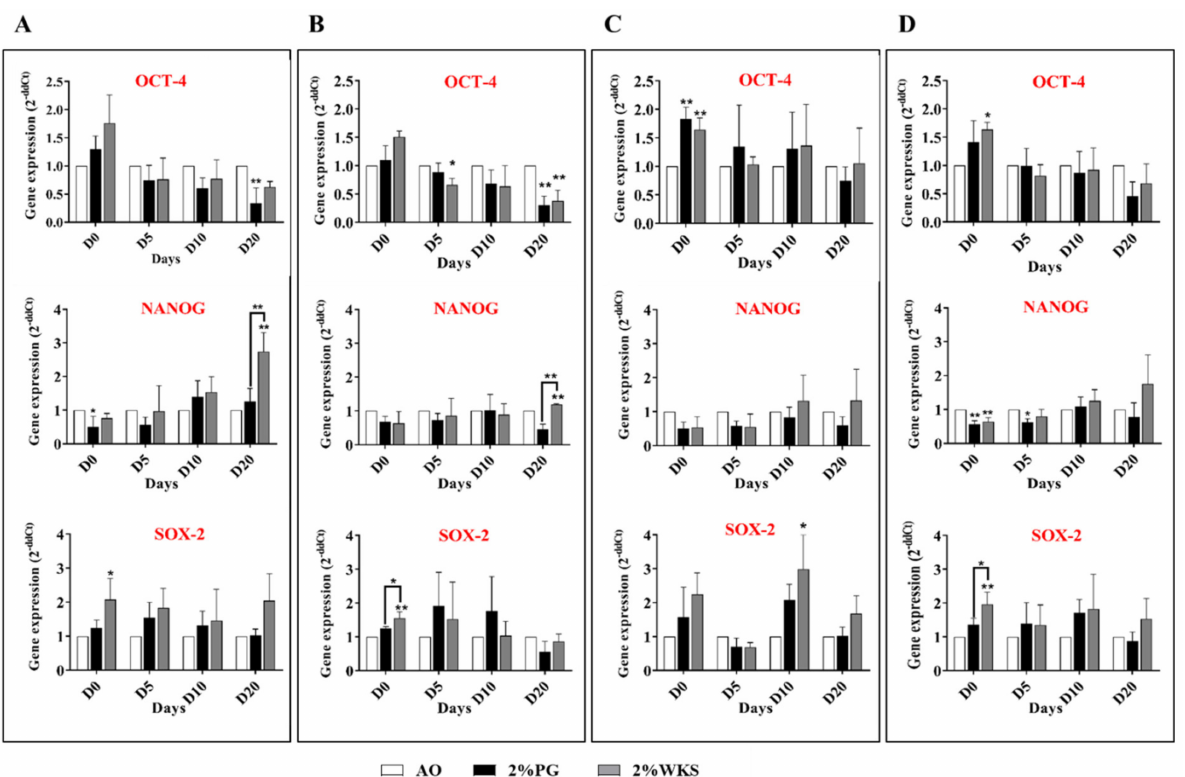
Figure 2. QRT-PCR analysis of OCT-4, SOX-2 and NANOG expression. ( A ) SHEF1, ( B ) SHEF2, ( C ) ZK2012L, and ( D ) Pooled PSCs-profile, (SHEF1, SHEF2 and ZK2012L) . The internal control, ACTB, was used to normalize expression. Y -axis shows the relative changes in 2 − ∆∆ CT of air oxygen (AO) to physoxia cultured cells. The X -axis indicates time (days). Data are presented as a mean ( n = 3), * p < 0.05, ** p < 0.01 vs. 21% AO, connecting lines indicate significance between conditions, and error bars indicate